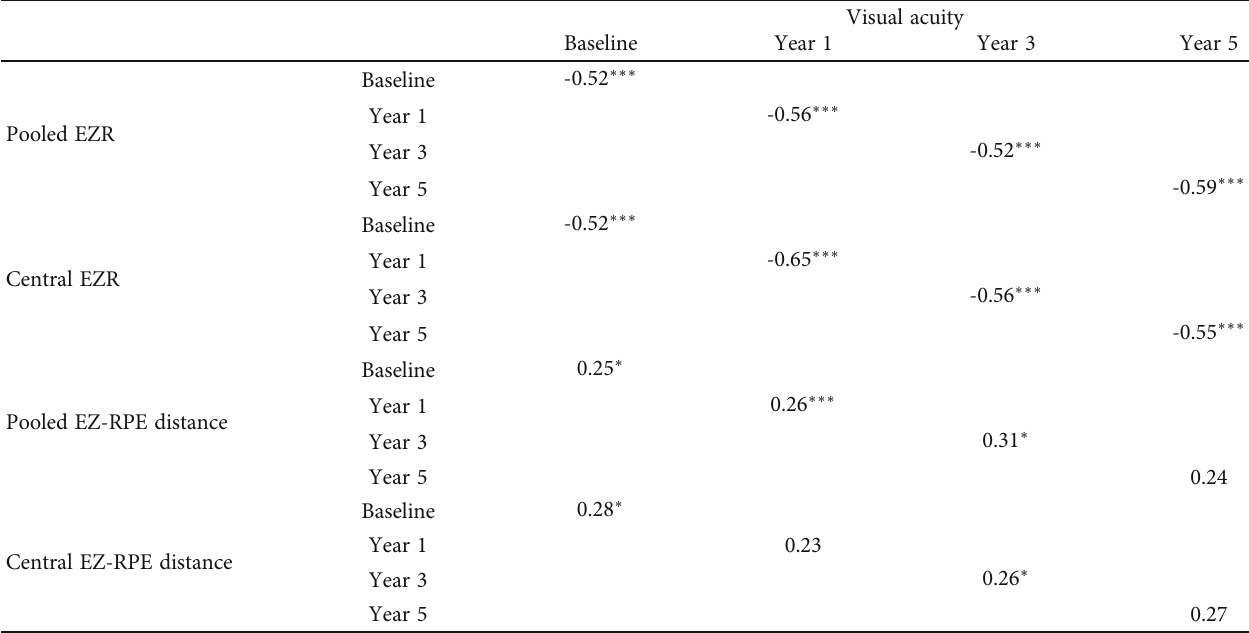
Table 2: Correlation analysis of visual acuity and OCT parameters at baseline, 1, 3, and 5 years. Spearman ’ s correlation coe ffi cient ρ between visual acuity and OCT parameter at each time point is shown. ∗ p < 0 : 05 ; ∗∗ p < 0 : 01 ; ∗∗∗ p < 0 : 001 .